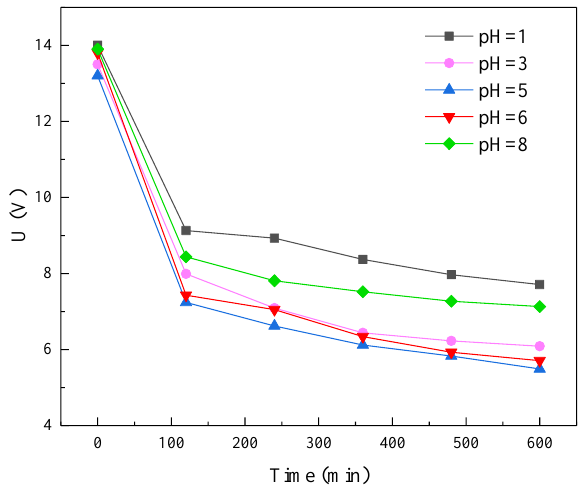
Figure 4. Desalination degree under different pH values.